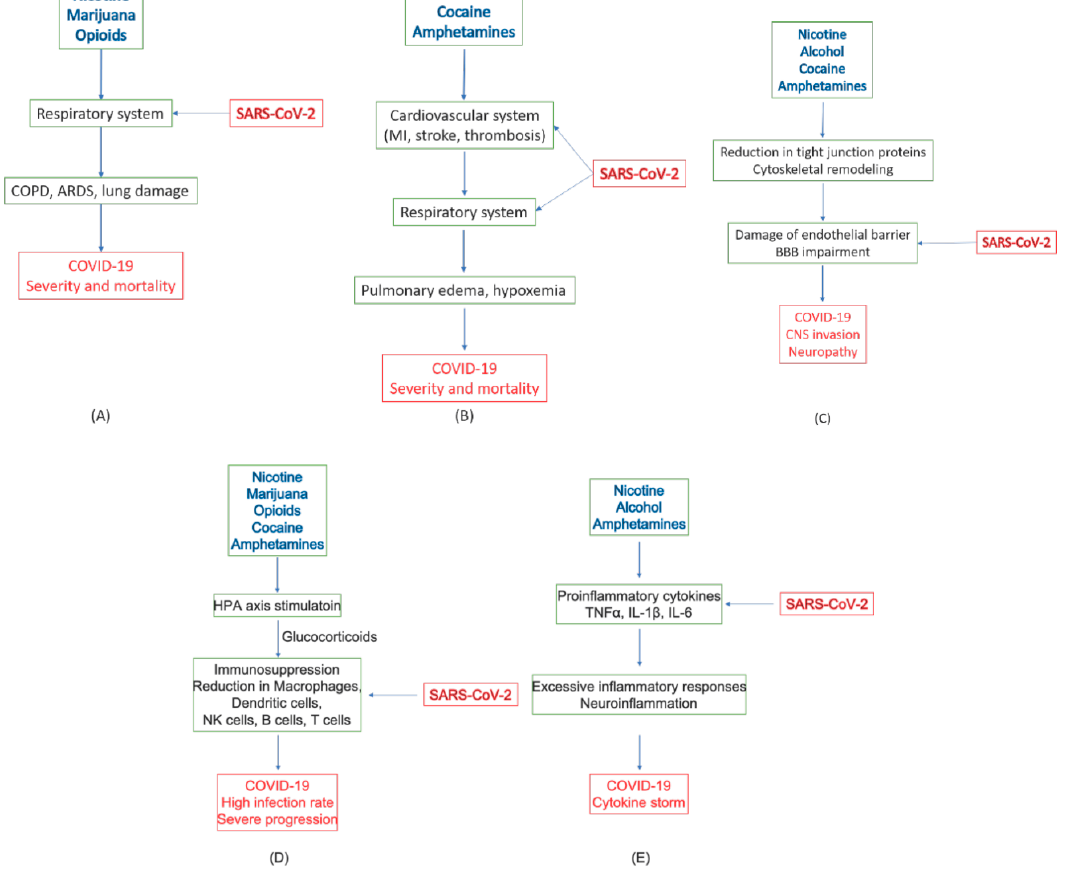
Figure 4. Pathological effects of substances of abuse on various tissues and systems and their implied complications in COVID-19. ( A ) Respiratory system; ( B ) Cardiovascular system; ( C ) Vascular endothelium; ( D ) HPA axis stimulation and immunosuppression; ( E ) Proinflammation and neuroinflammation. Table 3. Connection of substances of abuse to COVID-19.